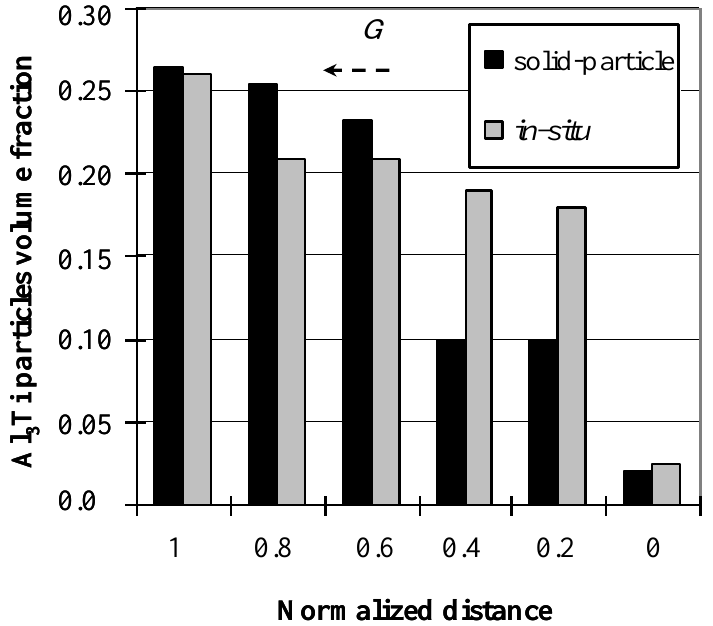
Figure 8. Volume fraction distribution of Al Al-Al Ti CM-FGM ring 3